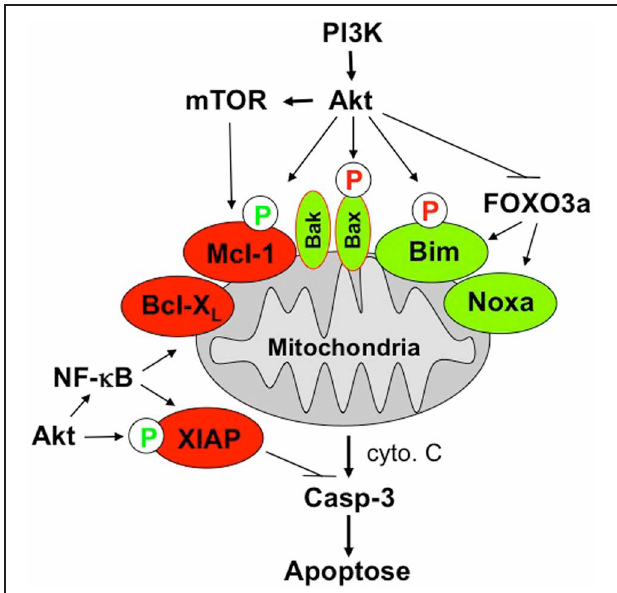
FIGURE 1 | Scheme of PI3K/Akt/mTOR-imposed antiapoptotic signaling at the mitochondria. See text for